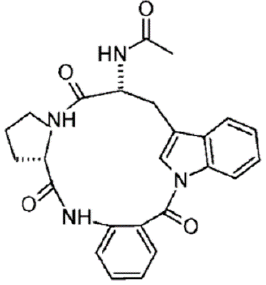
Figure 14. Structure of psychorophilin E